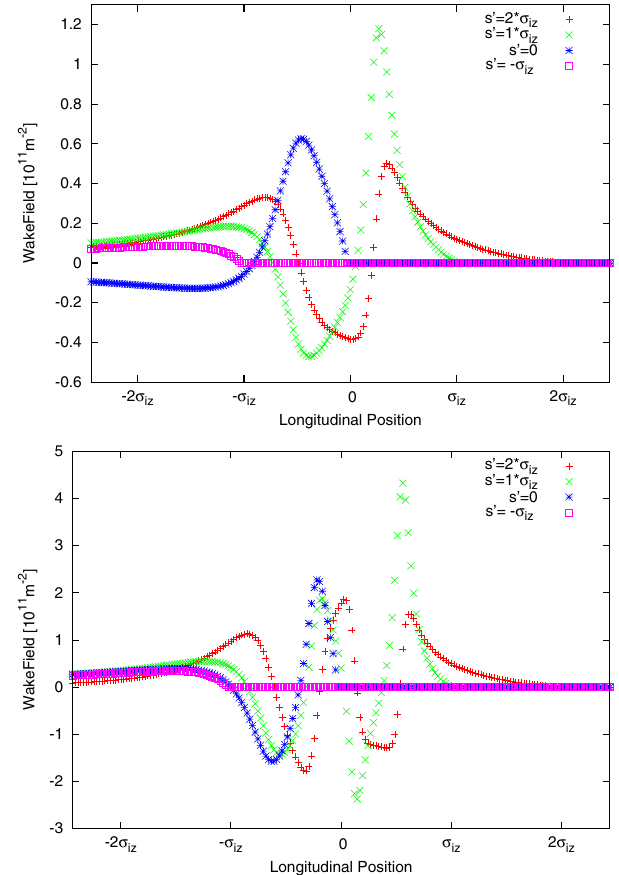
FIG. 1. Two examples of the kink wakefield with the beam- beam parameter of the ion beam (cid:6) p ¼ 0 : 015 . Top: The electron beam disruption parameter d e ¼ 27 ; bottom: d e ¼ 108 . In both figures, the electron bunch travels from the positive s to negative. s 0 denotes the location of the introduced